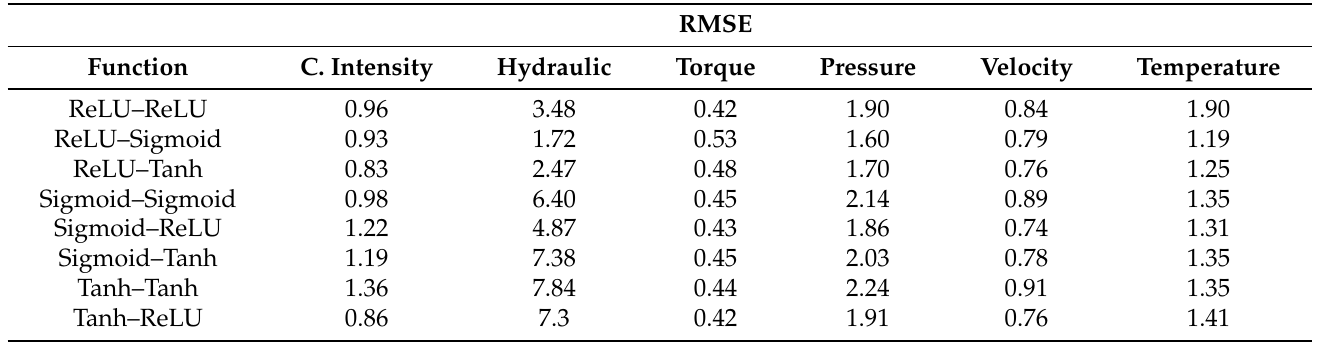
Table 6. Average RMSE obtained for the six variables, with different activation functions, calculated after the values were smoothed with a median filter.